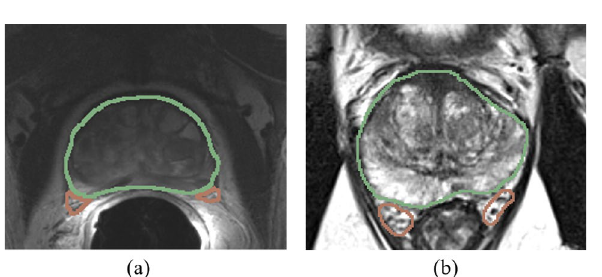
Figure 3. Example images of ( a ) intraoperative endorectal coil acquisition and ( b ) diagnostic pelvic coil acquisition. segmentation of the prostate (green), NVB (brown) and EUS (yellow) are overlayed. It can be seen that the shape, appearance and location of NVB varies as the endorectal coil compresses the tissue during